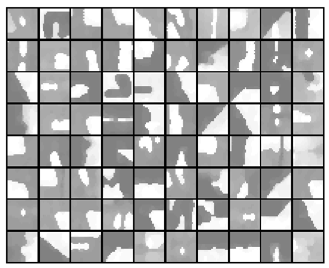
Figure 3. The templates in 32×32 window